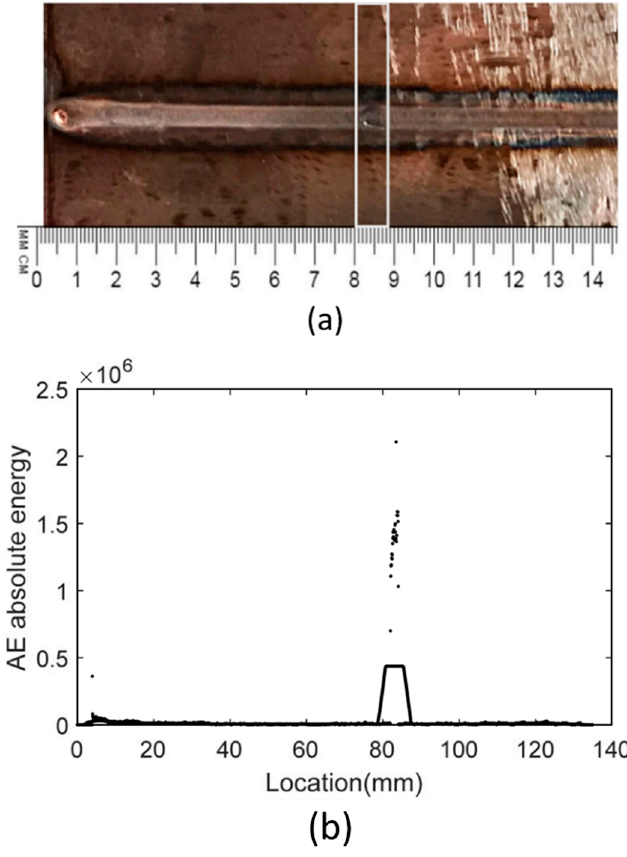
Figure 9. A correlation between acoustic emission absolute energy and welding defect [87]. ( a ) depicts the inspected sample. ( b ) shows the acquired AE absolute energy of the inspected weld seam.